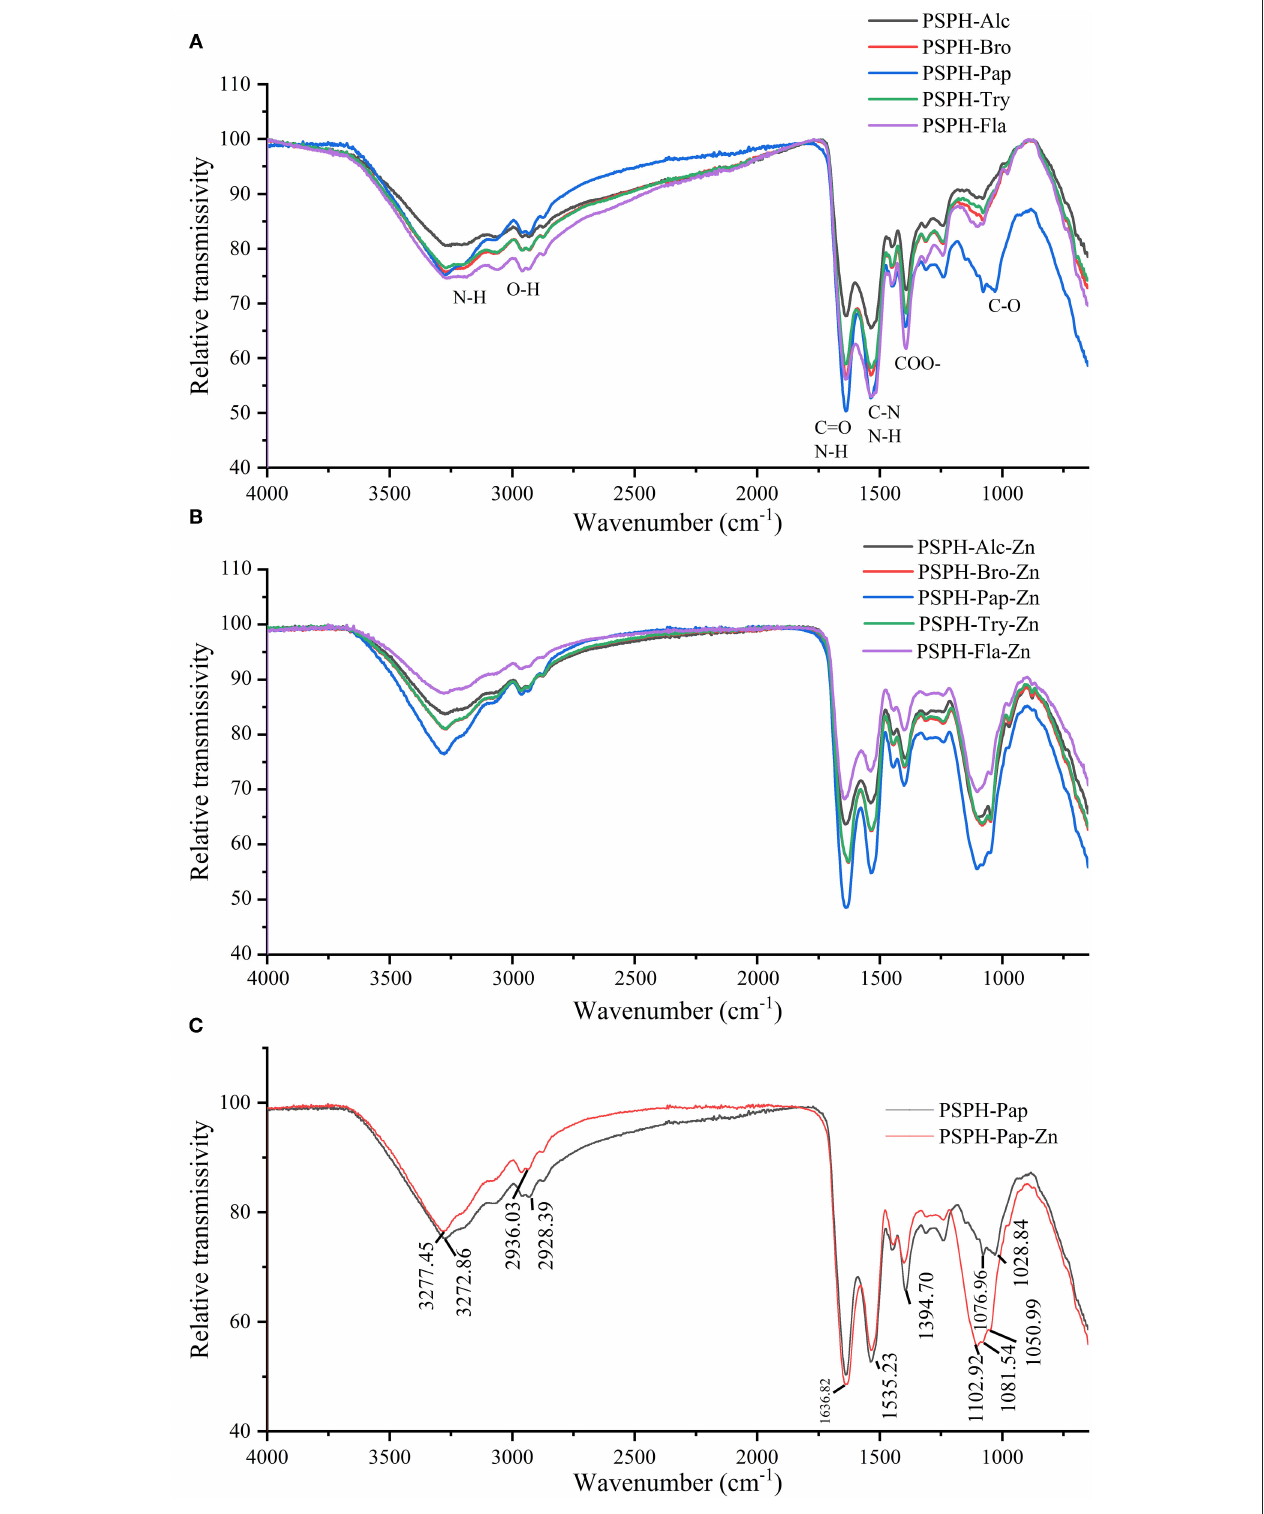
FIGURE 6 | Attenuated total reflection fourier transform infrared spectra (ATR-FTIR) of (A) pumpkin seed protein hydrolysates (PSPHs) in the range of 4,000 to 400 cm − 1 ; (B) pumpkin seed protein hydrolysates (PSPH) zinc chelates; (C) pumpkin seed protein hydrolysate hydrolyzed by papain (PSPH-Pap, black line) and its zinc complex (PSPH-Pap-Zn, red